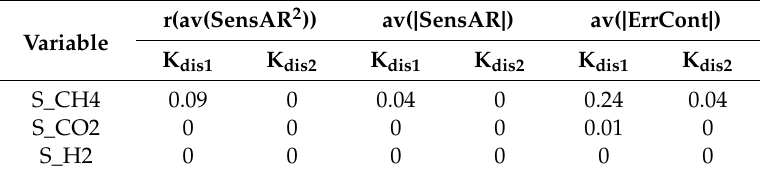
Table A3. Variables ranked based on sensitivity to K dis1 and K dis2 in the headspace (CF).